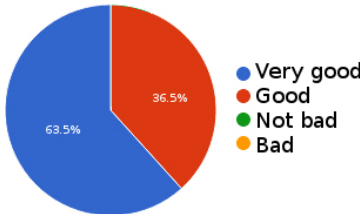
Figure 10. General assessment of the educational proposal by teaching